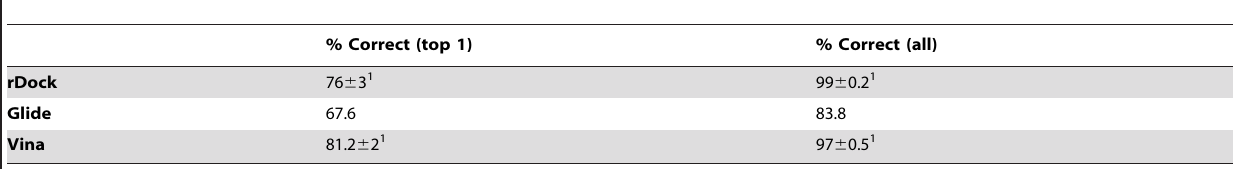
Table 2. Percentage of top-ranked poses with an RMSD below 2 A˚.